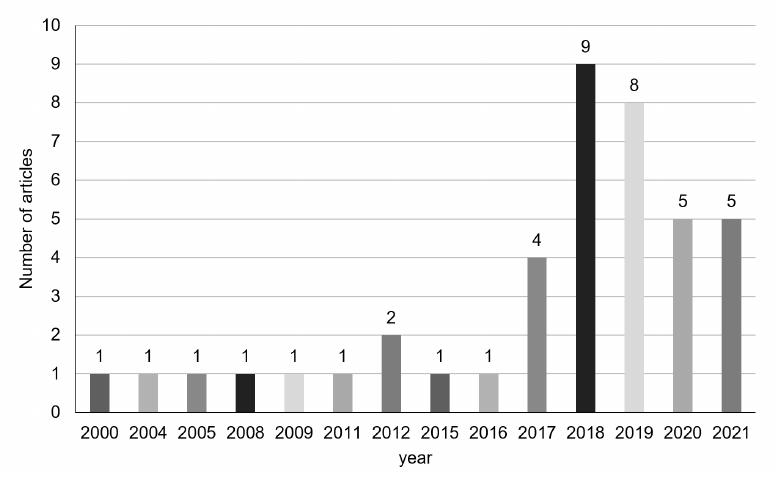
Figure 3. References according to year of publication.